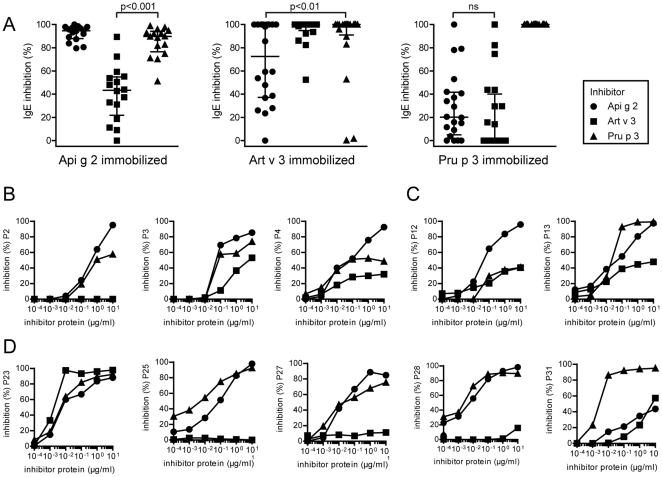
IgE cross-reactivity of LTP sensitized patients.Single point highest inhibition-achievable assays were performed using rApi g 2, rArt v 3, and nPru p 3 for pre-incubation of individual sera (A). Cross-inhibition was tested using the allergen microarray and values are expressed as percentage of IgE inhibition. Data were analyzed using the Wilcoxon signed rank test, the median is shown as solid line and whiskers indicate the interquartile range. Inhibition to solid-phase coated rApi g 2 was evaluated in ELISA using sera of patients with symptoms to raw celery stalks (B) or those consuming solely cooked celery (C), and asymptomatic patients (D). Sera were pre-incubated with increasing concentrations (10−4 to 101 µg/ml) of purified LTP and values are given as percentage of inhibition.